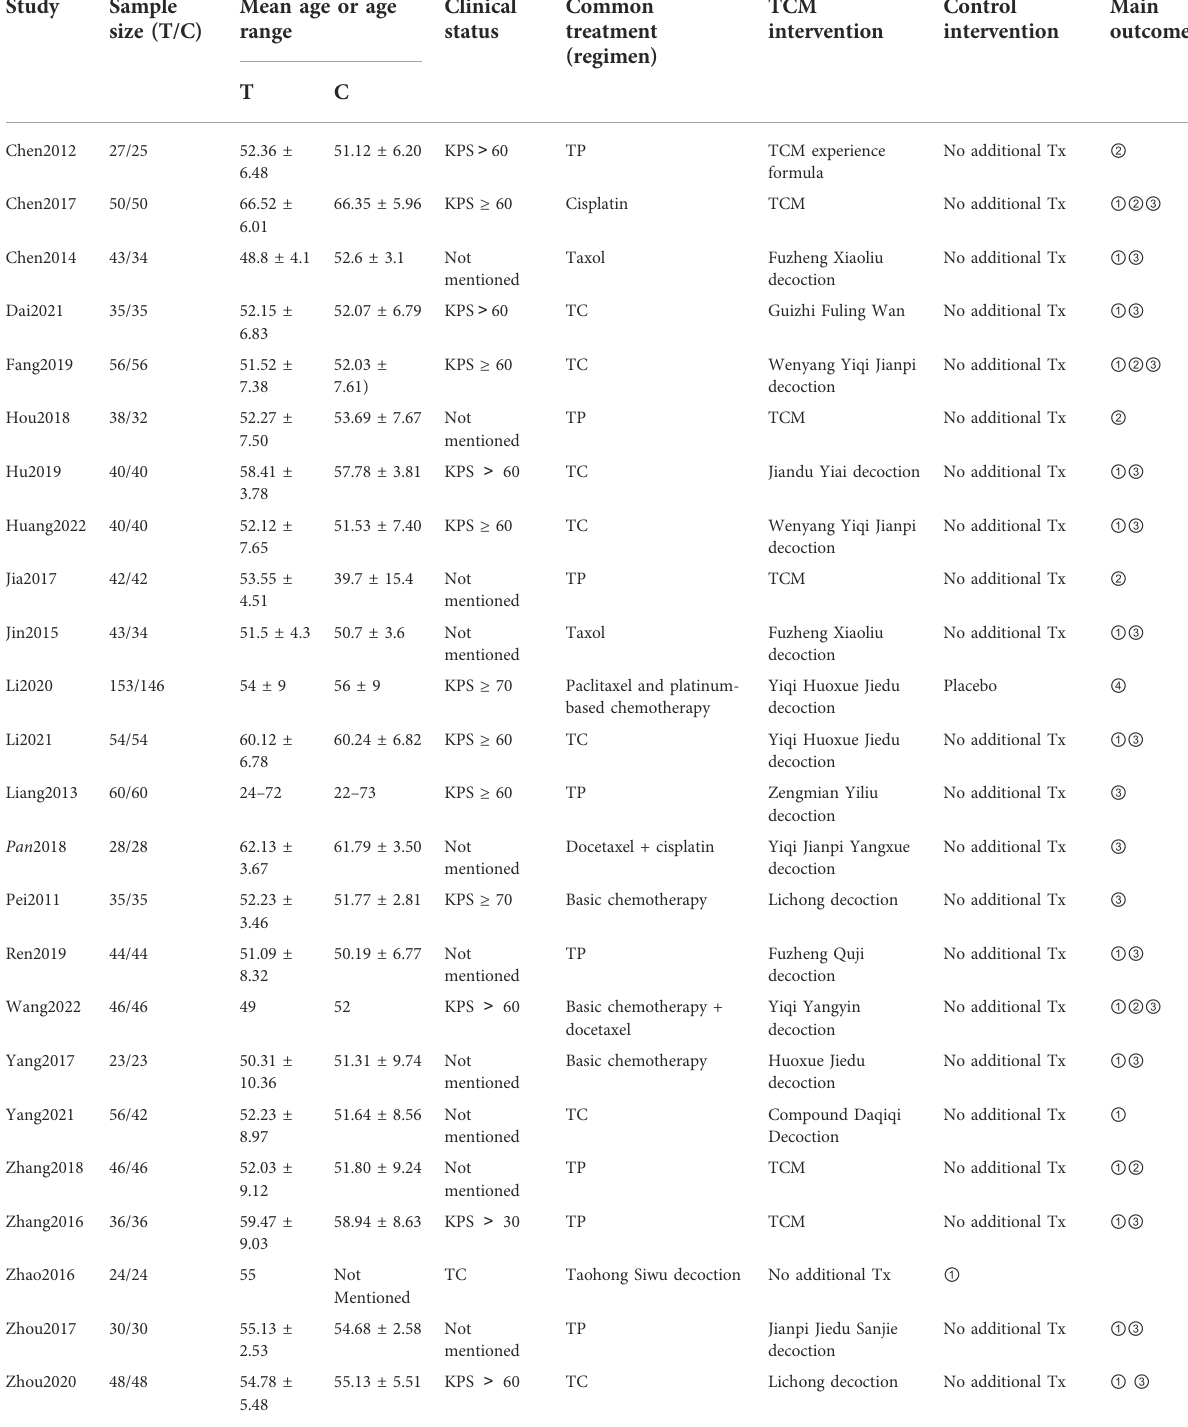
TABLE 2 Characteristics of the 24 studies included in the